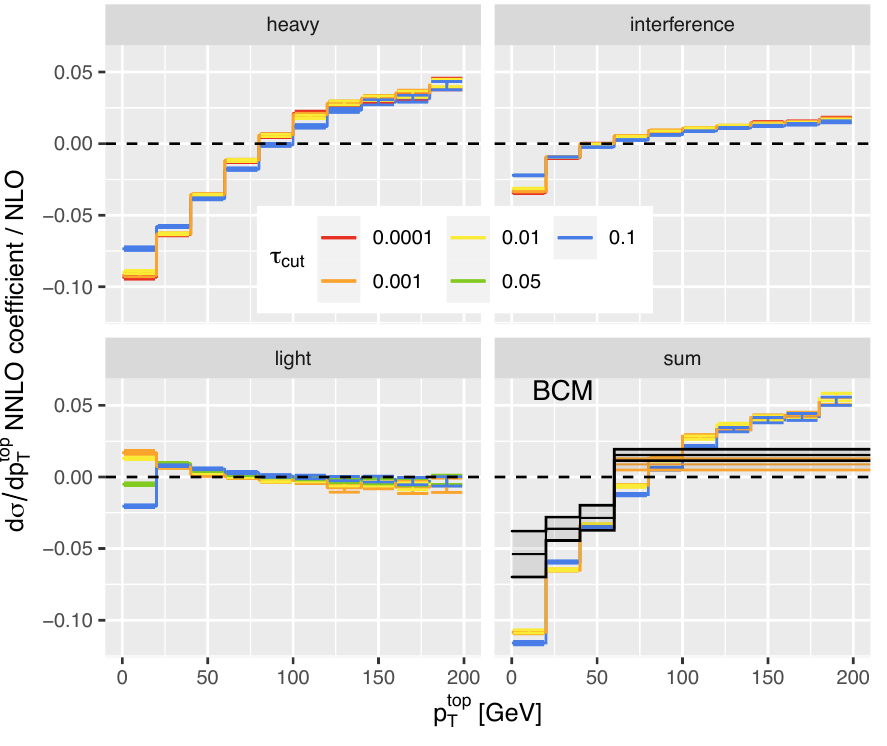
Figure 8 . τ cut dependence of NNLO light, heavy, interference and summed contributions relative to the NLO part for the top-quark p T distribution as input to table 2. The black points with error bars represent the reconstructed results from Brucherseifer, Caola, Melnikov (BCM) [36], see table 2, with an absolute uncertainty of ± 0 . 1 pb